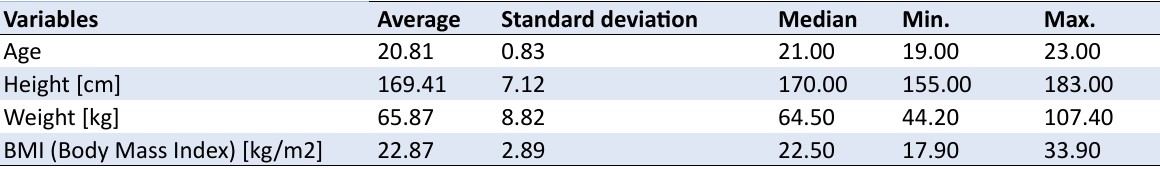
Table 1. Number characteristics of the female students participating in the study